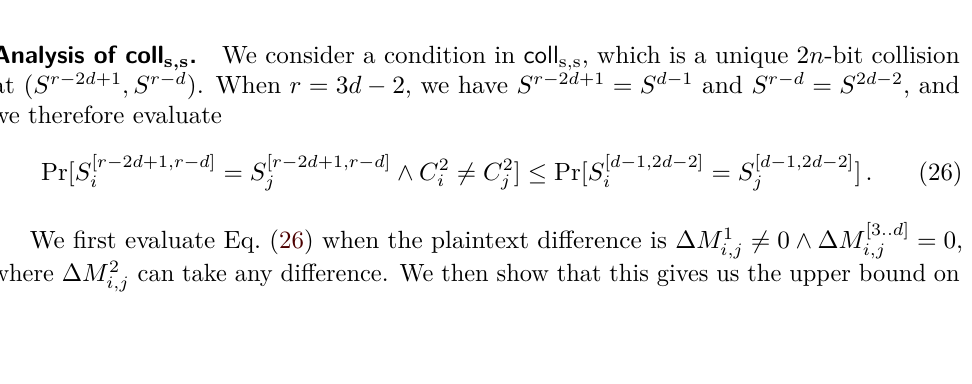
is, we evaluate the probabilities of ∆ S 3 ∥ ∆ S 6 = 00, ∆ S 4 = 0, ∆ S 5 = 0, and ∆ S 6 =